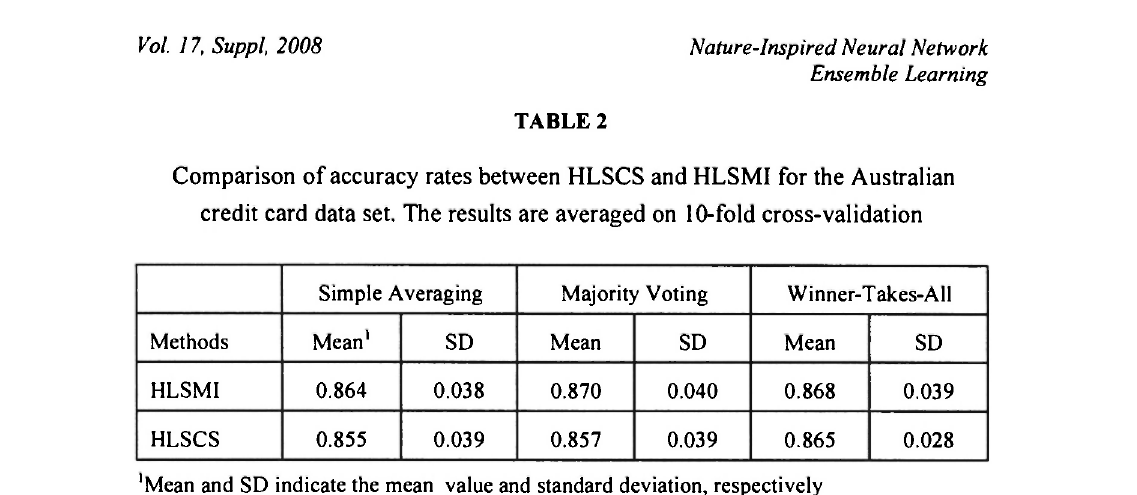
Comparison of accuracy rates between HLSCS and HLSMI for the diabetes data set. The results are averaged on 12-fold cross-validation. Mean and SD indicate the mean value and standard deviation,